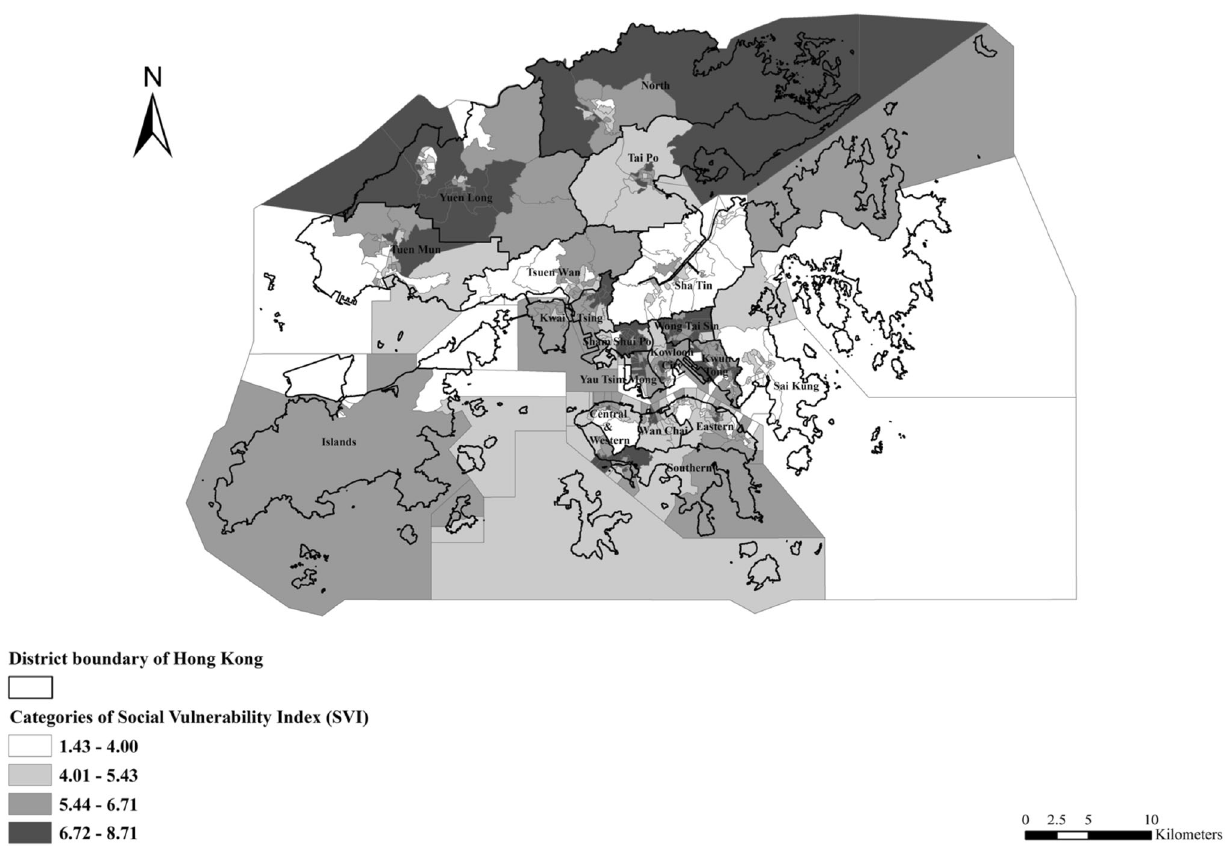
Fig. 2 SVI for elders across constituency areas of Hong Kong,